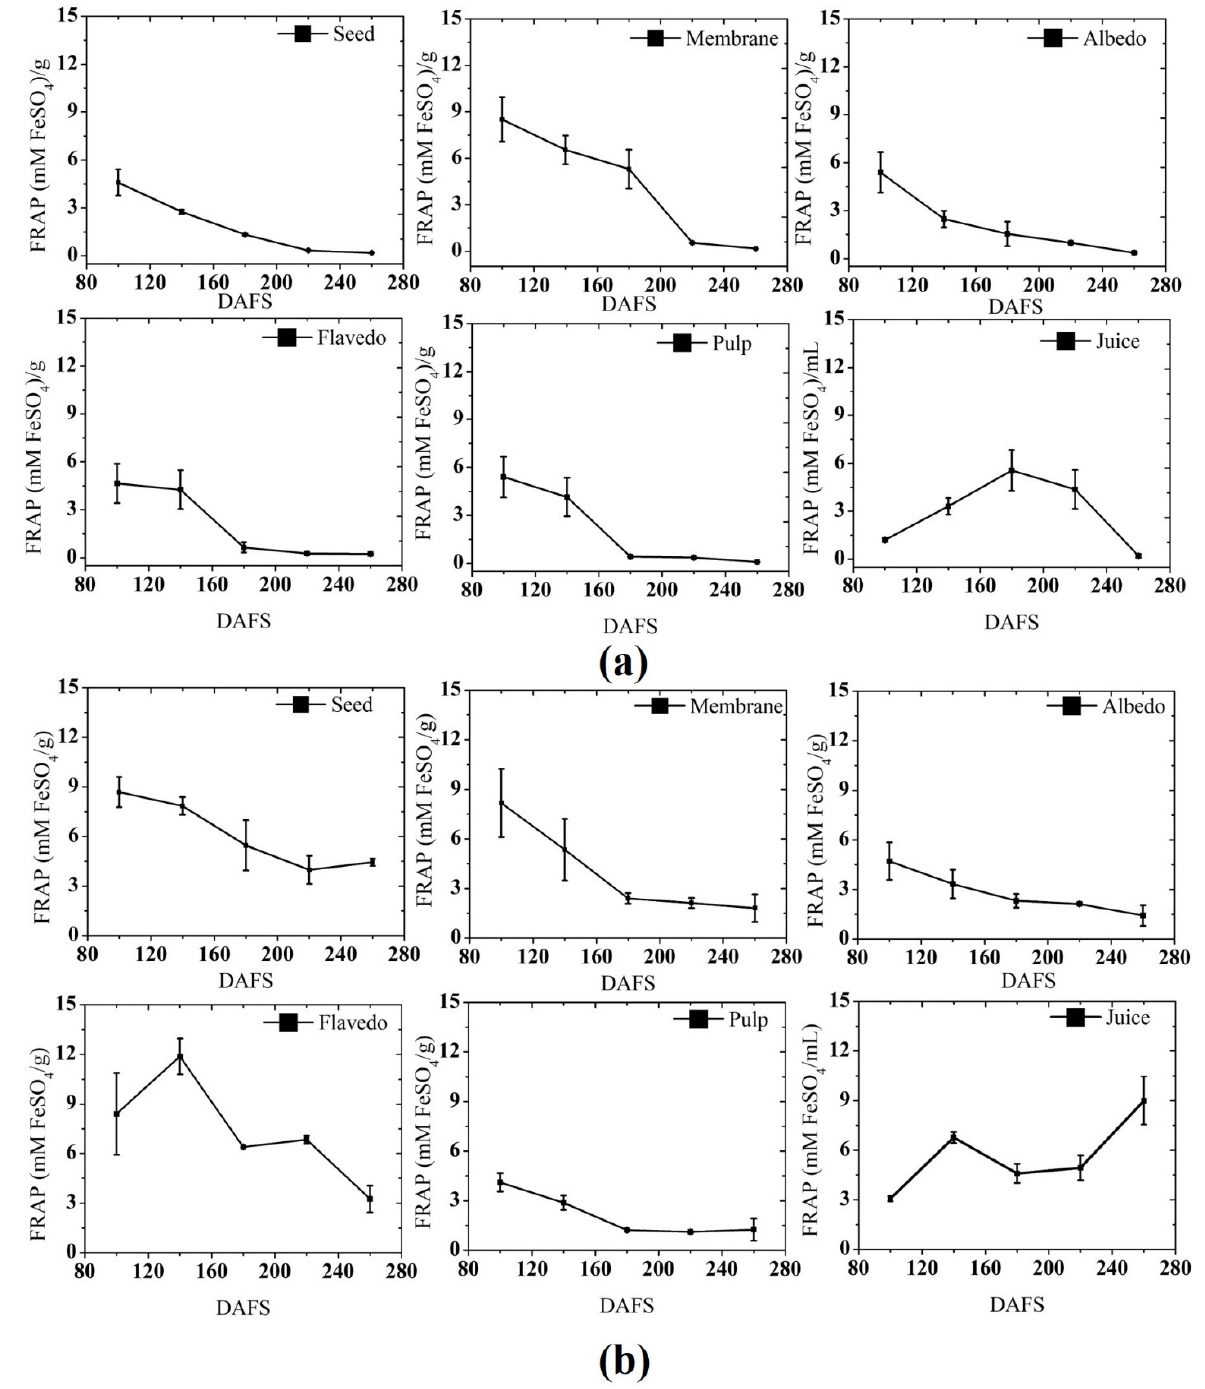
Figure 8. Ferric reducing antioxidant power in ( a ) 2018; and ( b ) 2019. DAFS: days after fruit set.